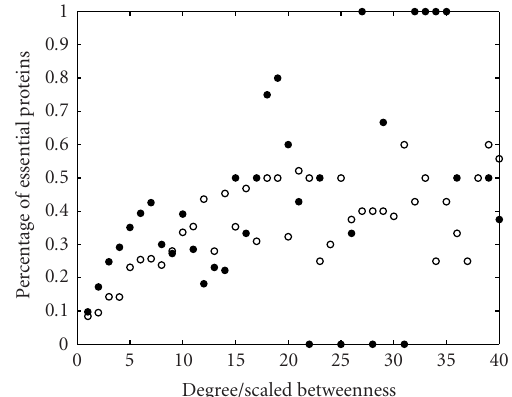
Figure 4. Percentage of essential genes with a particular degree (open circle) or betweenness (filled circle). Betweenness is scaled in such a way that the maximum value of betweenness is equal to the maximum degree. The plot was truncated at k/B = 40, since the number of essential genes beyond that is too small to have statistical